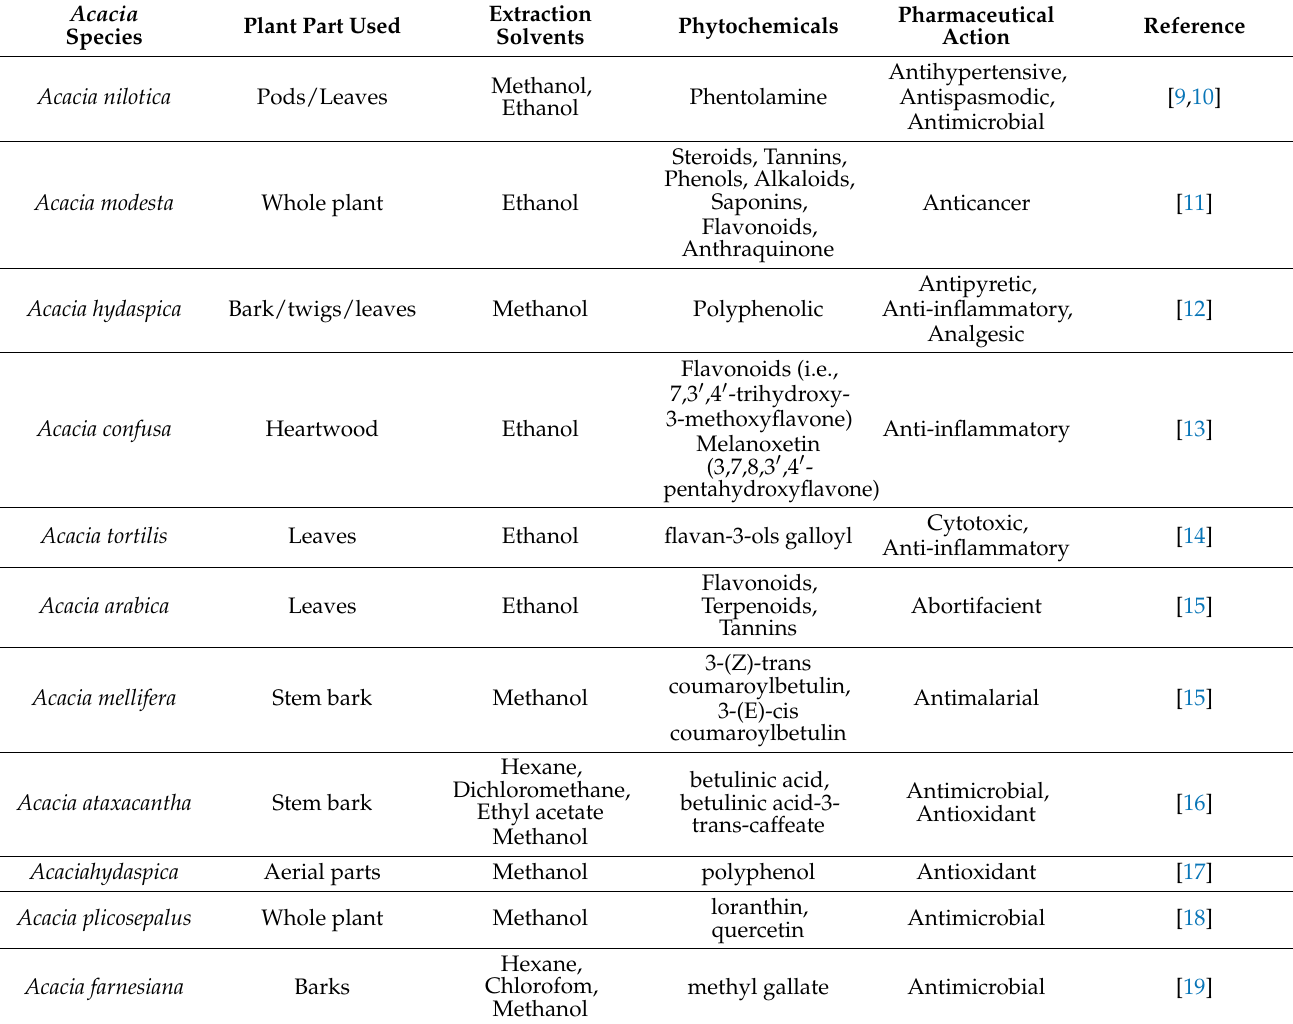
Table 1. Biochemical components and pharmacological properties of different species of genus Acacia